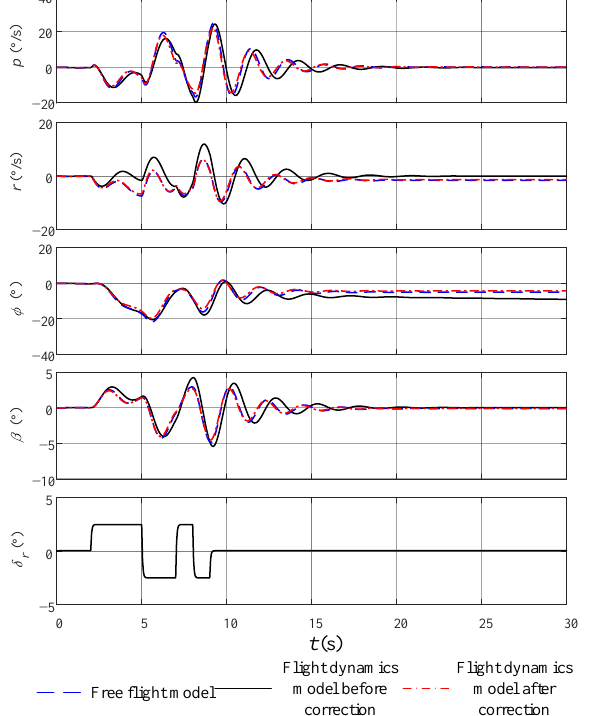
Figure 20. Comparison of the identification model for wind tunnel virtual flight before and after correction with the free flight model. Table 6. Goodness of fit of the wind tunnel virtual flight test with free flight.